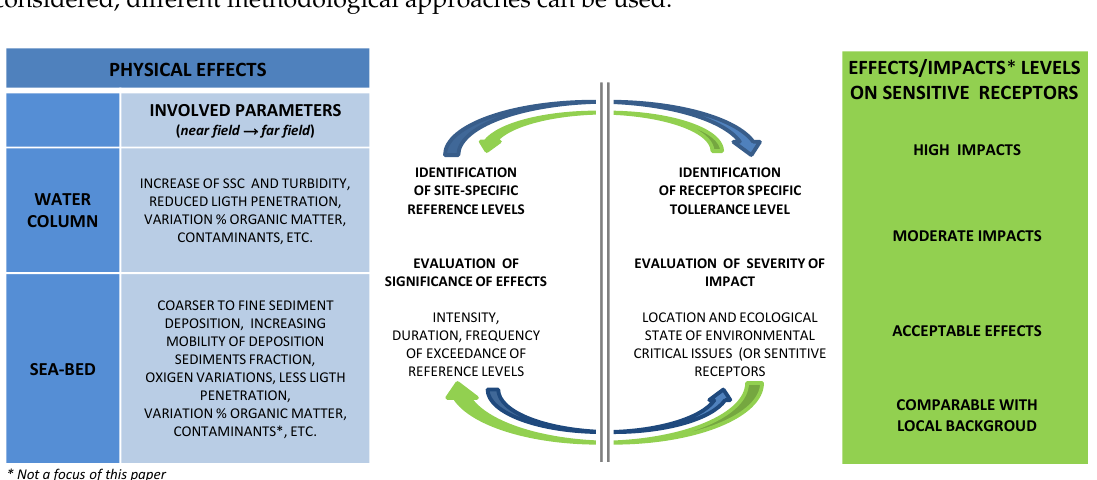
Figure 7. Scheme of the interactions between the significant physical effects related to the exceedance of reference levels (RLs) for SSC and sediment deposition rates (DEP) parameters and the severity of impact related to tolerance levels defined as a function of the status of sensitive receptors (if